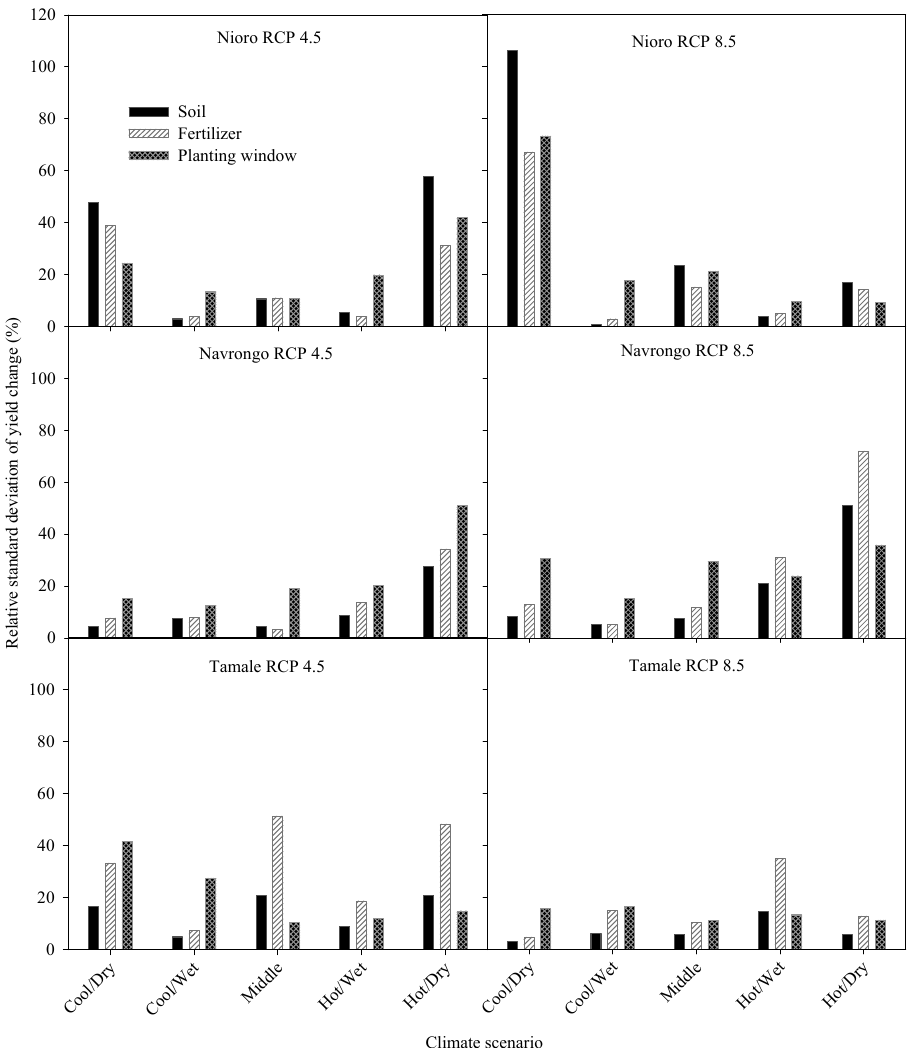
Figure 6. Contribution of differences in fertilizer levels, soil and planting window on the variability in the impacts of climate scenarios on yields among farms at Nioro, Navrongo and Tamale under RCP 4.5 and RCP 8.5. and RCP